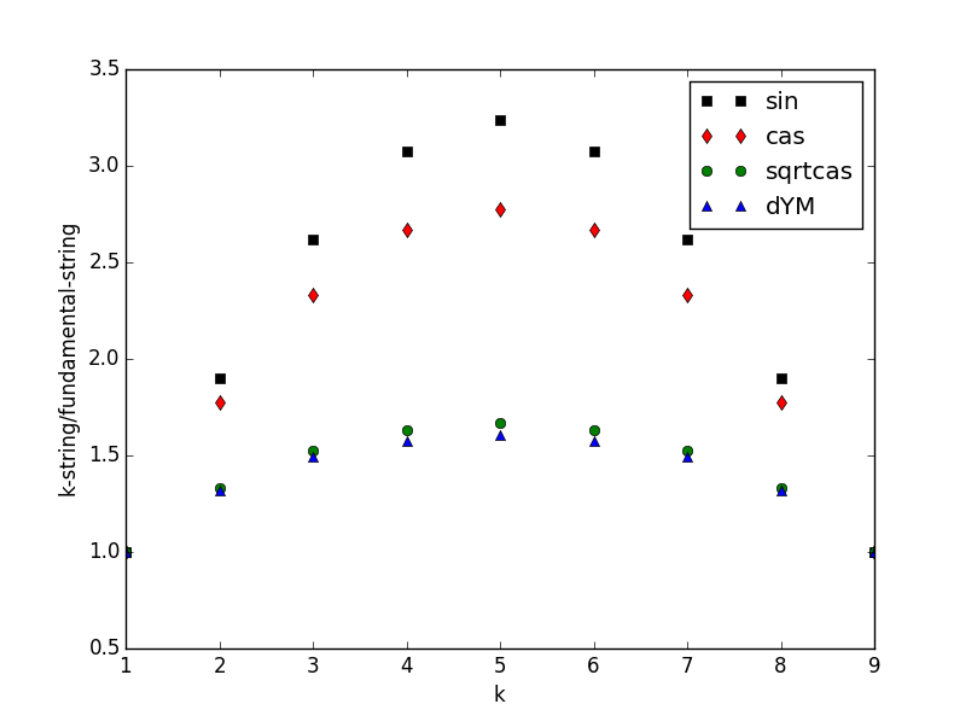
Figure 4 . Comparison of SU(10) k -string ratios of (5.6) with dYM k -string ratios, labeled by \dYM", to other k -string tension laws. The Sine law labeled by \sin", the Casimir scaling by \cas", and scaling with the Square root of the Casimir scaling by \sqrtcas". From the known theoretical models predicting di(cid:11)erent scalings of k -string tensions, the ones in dYM are closest to the MIT Bag Model \square root of Casimir" k -string tension law. There is a clear physical reason behind this similarity, explained in section